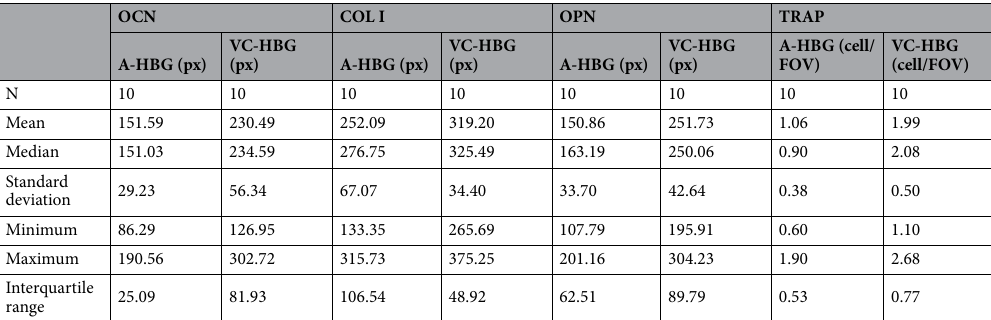
Table 3. Descriptive analysis of immunohistochemical quantitative variables by type of graft. A-HBG acellular-human bone graft, FOV field of view, px pixels, VC-HBG viable cryopreserved-human bone